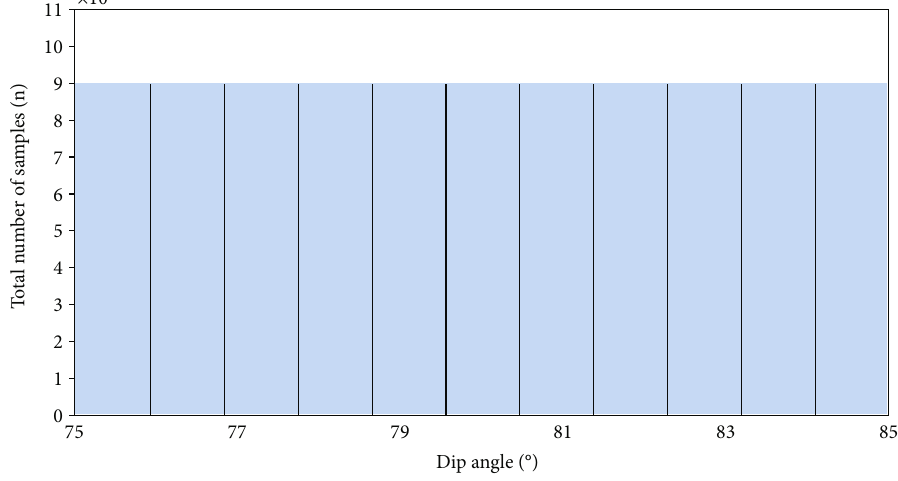
Figure 12: Statistical histogram of slope angle parameters.